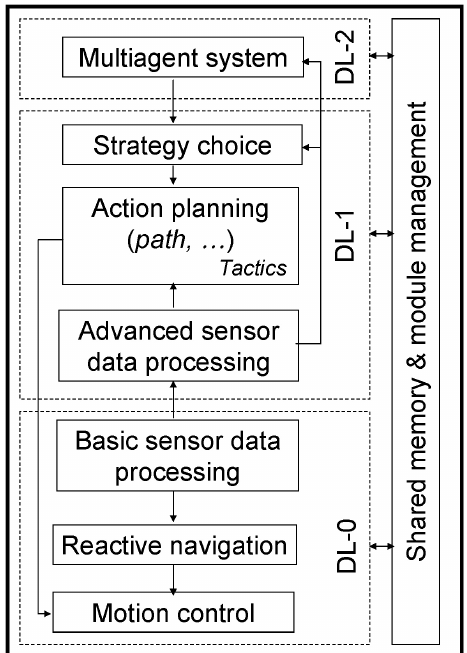
Figure 1. Basic information structure of a mobile robot configured by decision levels